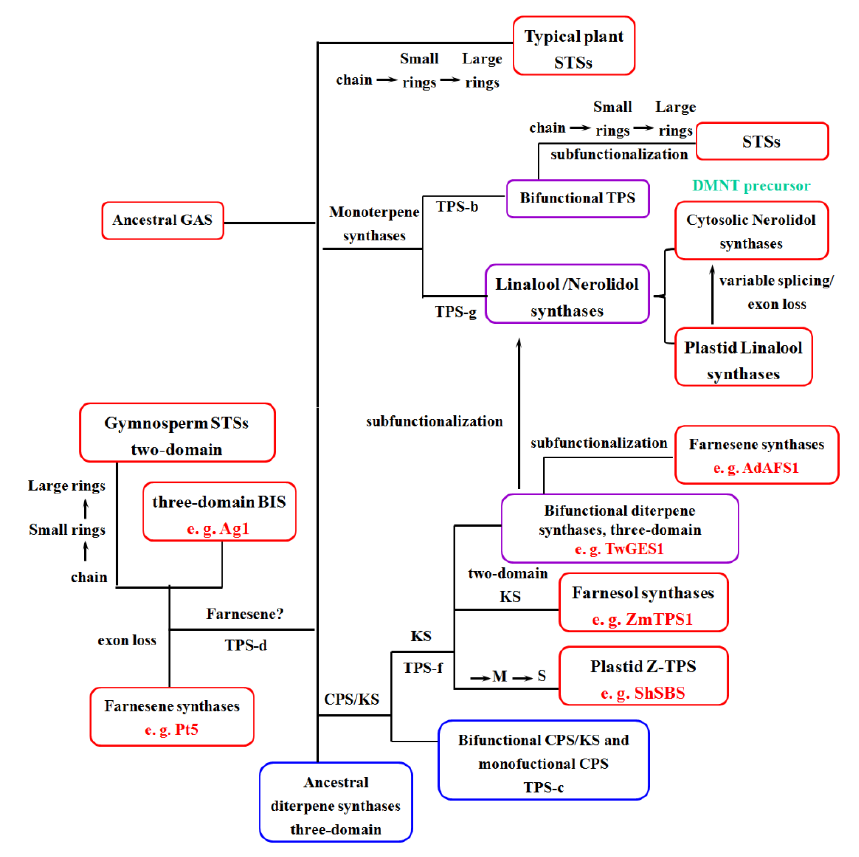
Figure 9. The proposed evolutionary history of spermatophyte STSs. Blue boxes represent ancestral TPSs, red boxes represent STSs, and purple boxes represent transition TPSs. The character “M” represents monoterpene synthases and the character “S” represents STSs. The red words represent the examples of STSs, the green words represent functional products of STSs.